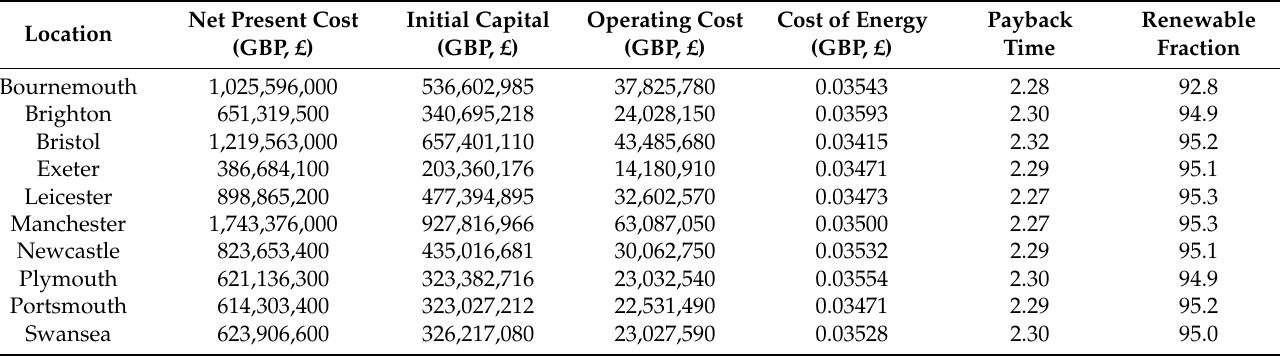
Table 9. Results for lowest Net Present Cost hybrid